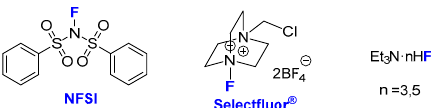
Figure 1. Mostly common electrophilic and nucleophilic fluorinating reagents .